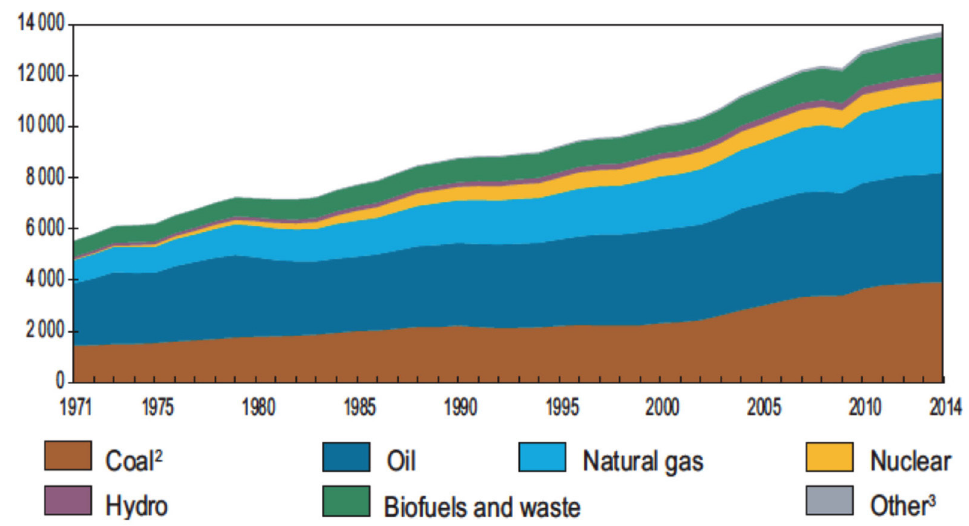
Fig. 2. – World 1 total primary energy supply (TPES) from 1971 to 2014 by fuel (Mtoe). 1 World includes international aviation and international marine bunkers. 2 In these graphs, peat and oil shale are aggregated with coal. 3 Includes geothermal, solar, wind, heat, etc. (Courtesy of IEA.)